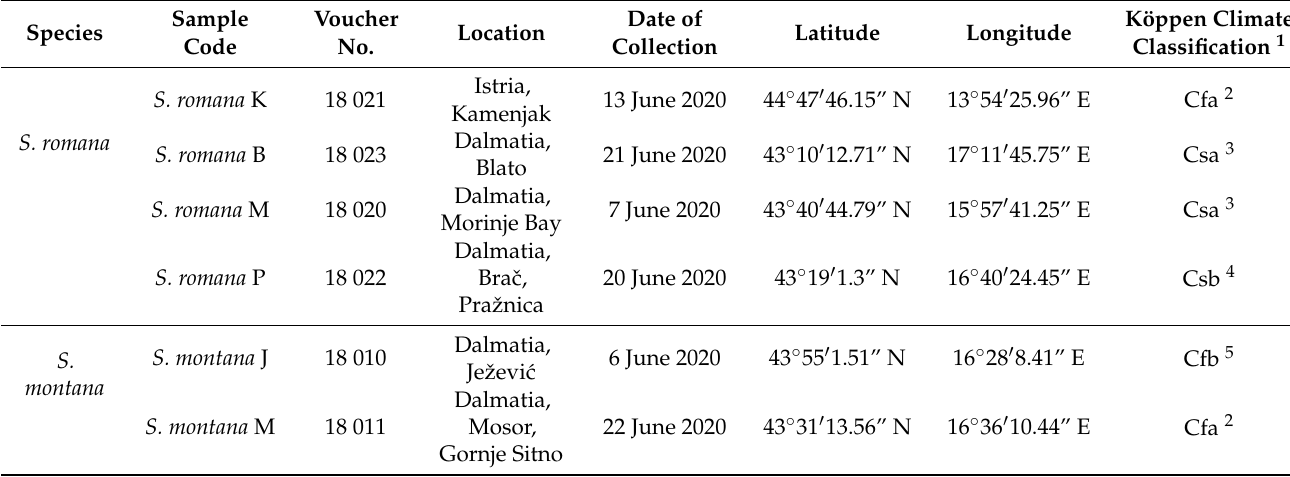
Table 4. Sample codes, voucher numbers, harvesting locations, geographic coordinates and climatic affiliations according to Köppen climate classification for investigated Sideritis